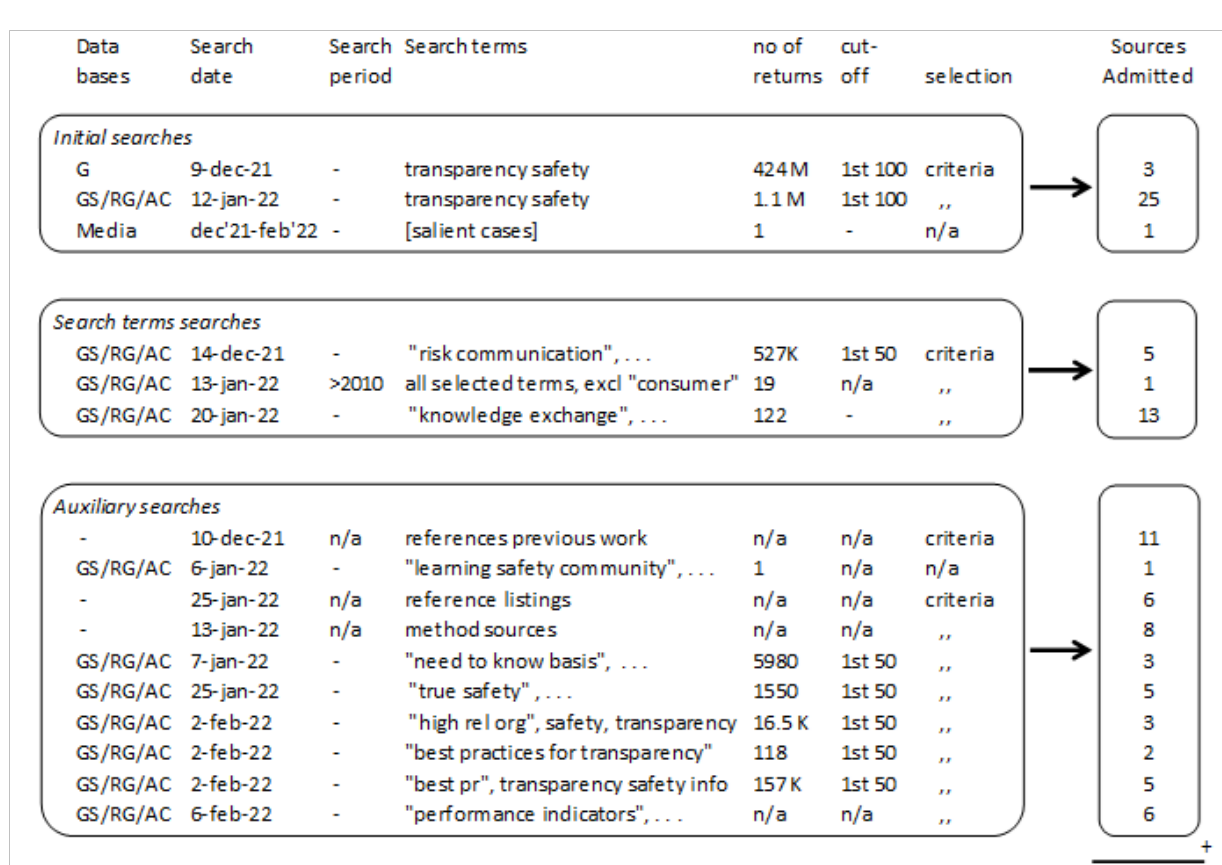
Figure 1. Search process and results. (G = Google; GS = Google Scholar; RG = ResearchGate; AC = Academia).